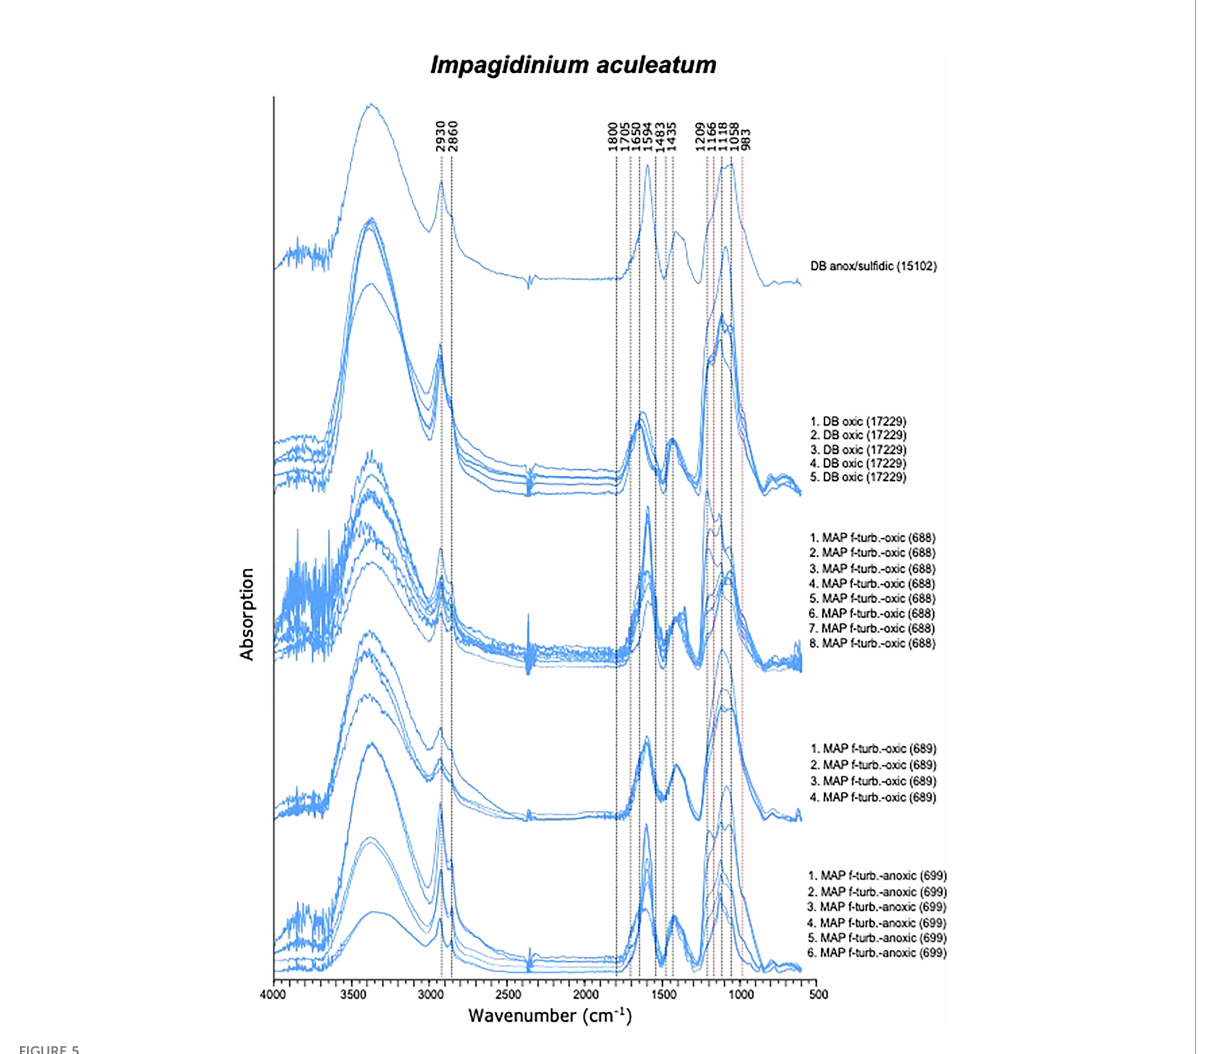
FIGURE 5 Micro-FTIR spectra of Impagidinium